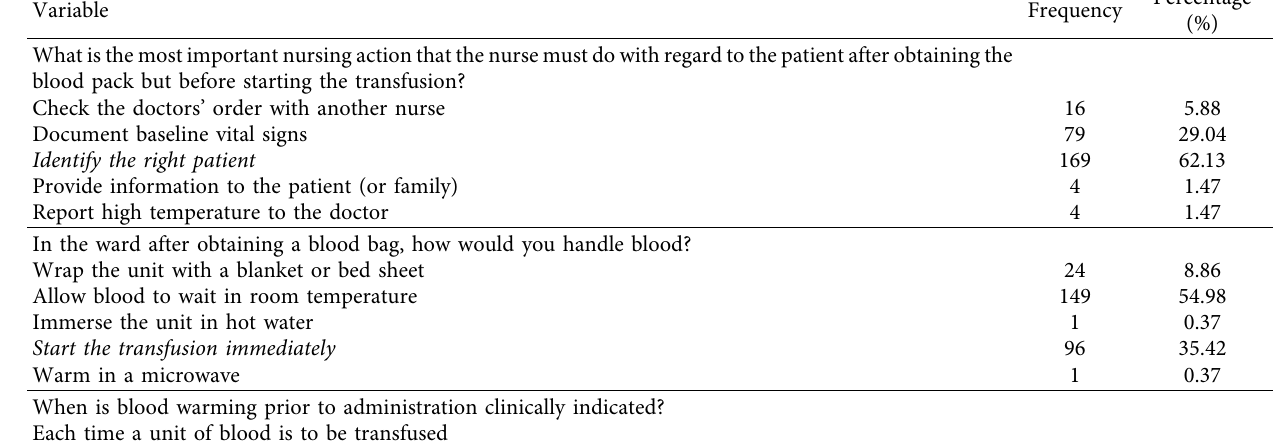
Table 4: Pretransfusion initiation nursing